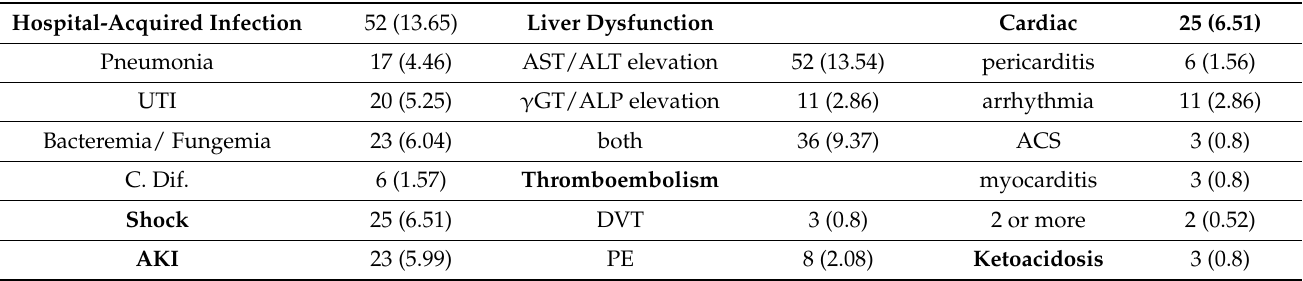
Table 4. Major complications during